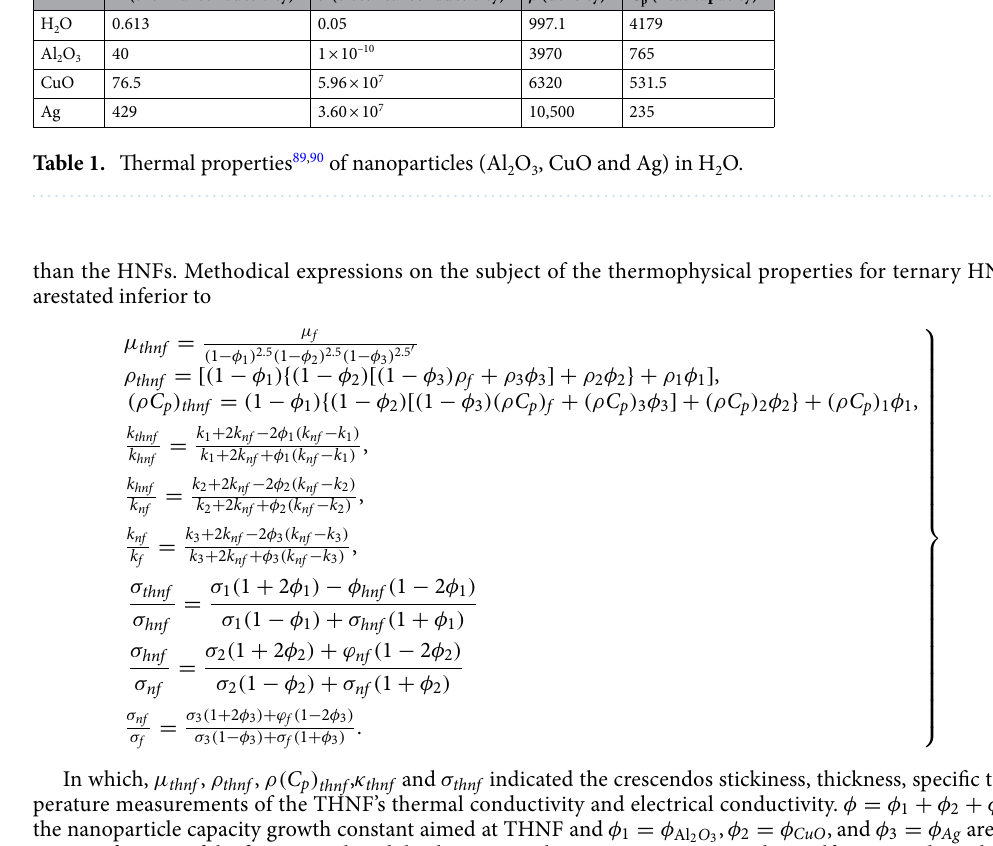
K (thermal conductivity) σ (electrical conductivity) ρ (density) C p (heat